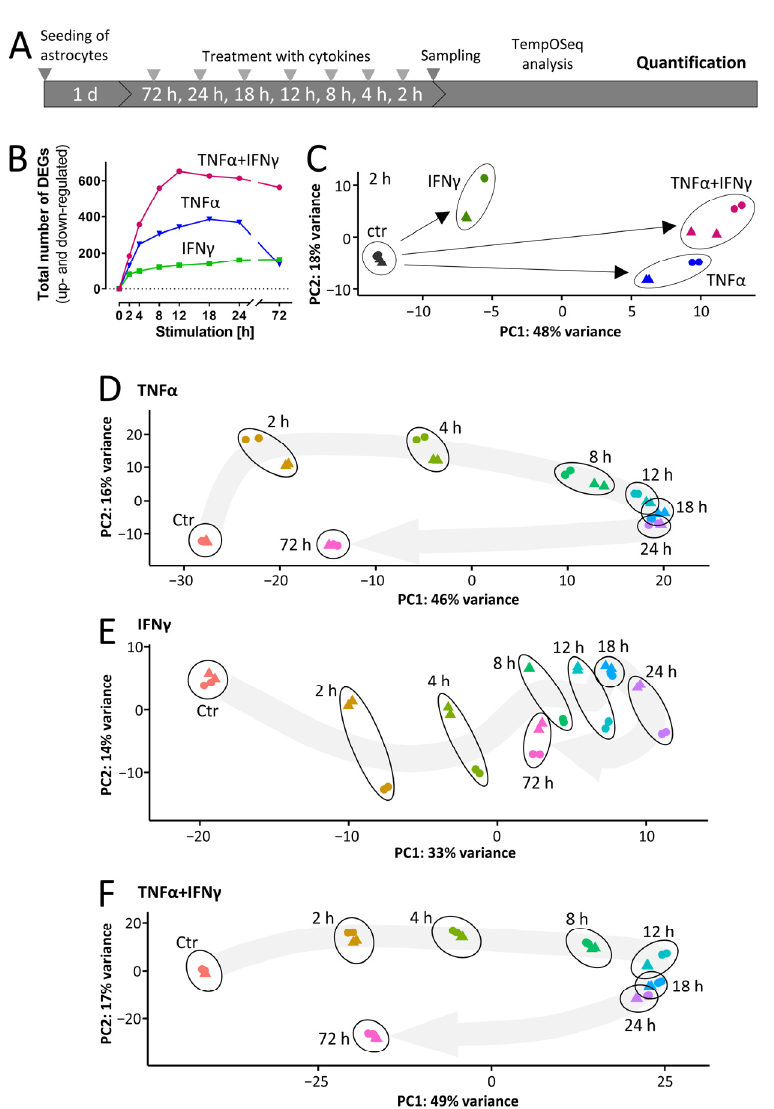
Figure 4. Dynamics of cytokine-induced gene expression in ACs. ( A ) Schematic representation of the experimental procedure for AC sample generation and targeted RNASeq analysis (TempOSeq method). ACs were seeded at a density of 50,000 cells/cm 2 into 96-well plates. On the following days, cells were stimulated with TNF α (10 ng/mL), IFN γ (20 ng/mL) or a combination of TNF α (10 ng/mL) plus IFN γ (20 ng/mL). After the indicated time periods, cells were lysed and gene expression profiling was performed for 3562 genes. ( B ) The total numbers of differentially expressed genes (DEGs) are depicted. Genes were considered as differentially expressed with p -value ≤ 0.05 (after false discovery rate adjustment) and an absolute log 2 fold change of ≥ 0.5. A full list of all genes and their regulation can be found in Supplementary Materials. ( C ) Principal component analysis (PCA) of the early transcriptome responses (2 h) to TNF α , IFN γ and co-treatment of TNF α plus IFN γ . Triangles and circles show samples belonging to one differentiation batch. The PCA axes are scaled according to the variance covered. ( D – F ) The time-dependent changes in gene expression in astrocytes in response to ( D ) TNF α , ( E ) IFN γ and ( F ) co-treatment with TNF α plus IFN γ were analyzed by principal component analysis (PCA). The first two PCA dimensions are shown with the axes scaled according to the variance covered. Triangles/circles indicate samples belonging to one differentiation batch. The gray arrows represent the overall trend of gene regulation, they are fitted to the average PCA position of the four